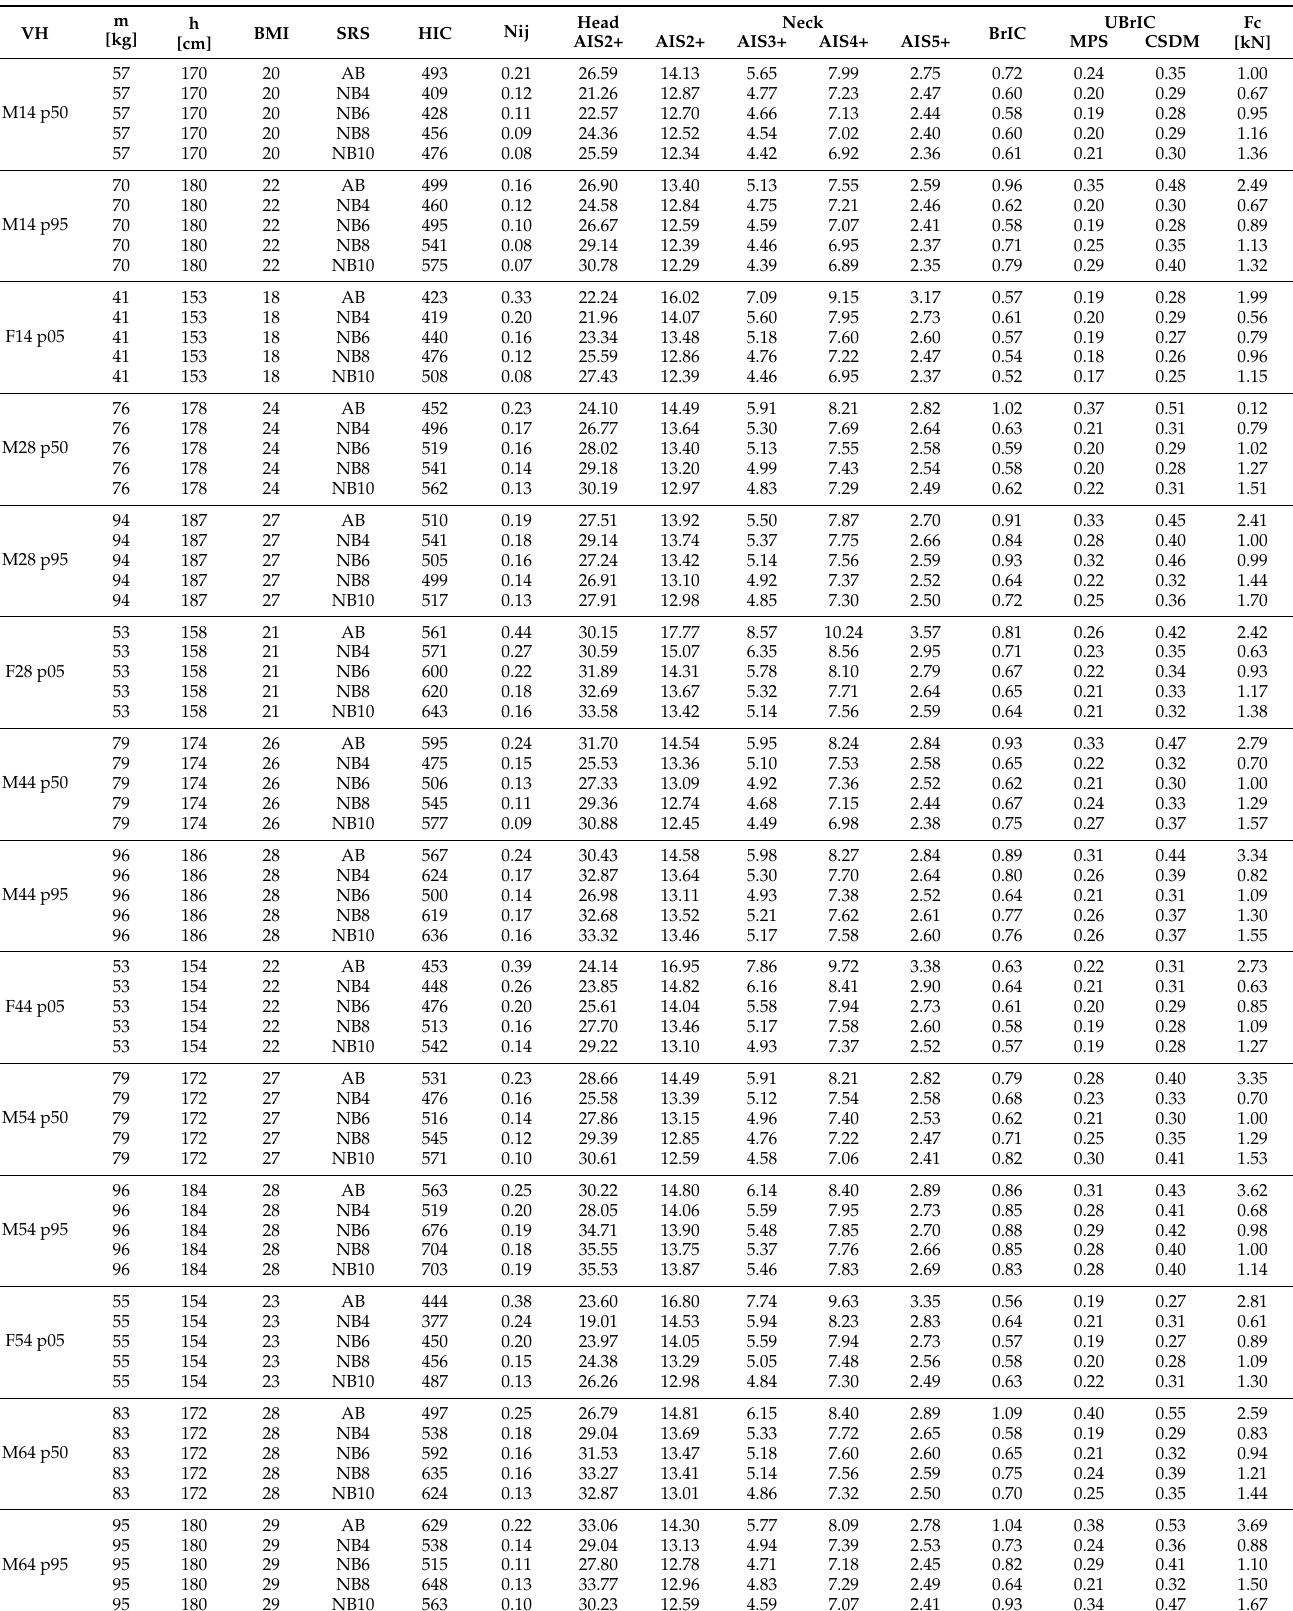
Table 4. Results of 50 km/h impact